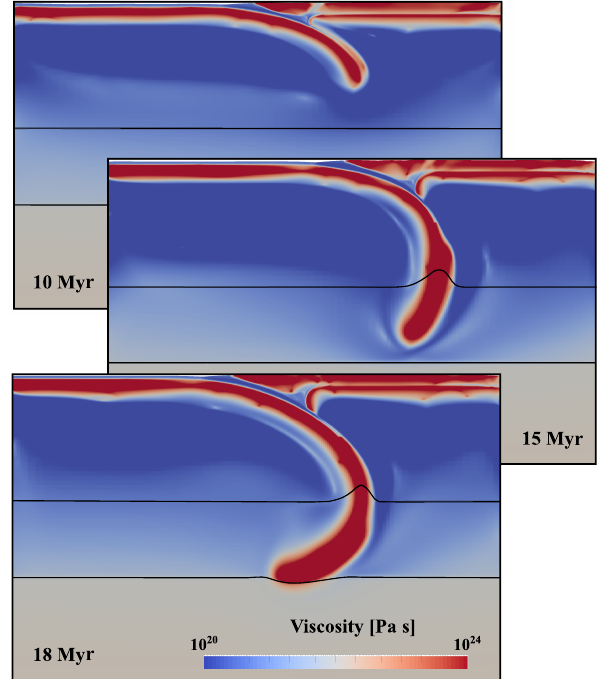
Figure B2. Compressible subduction evolution in terms of viscos- ity. Density is contoured at 3700 and 4200kgm − 3 , demonstrating phase boundary topography in the